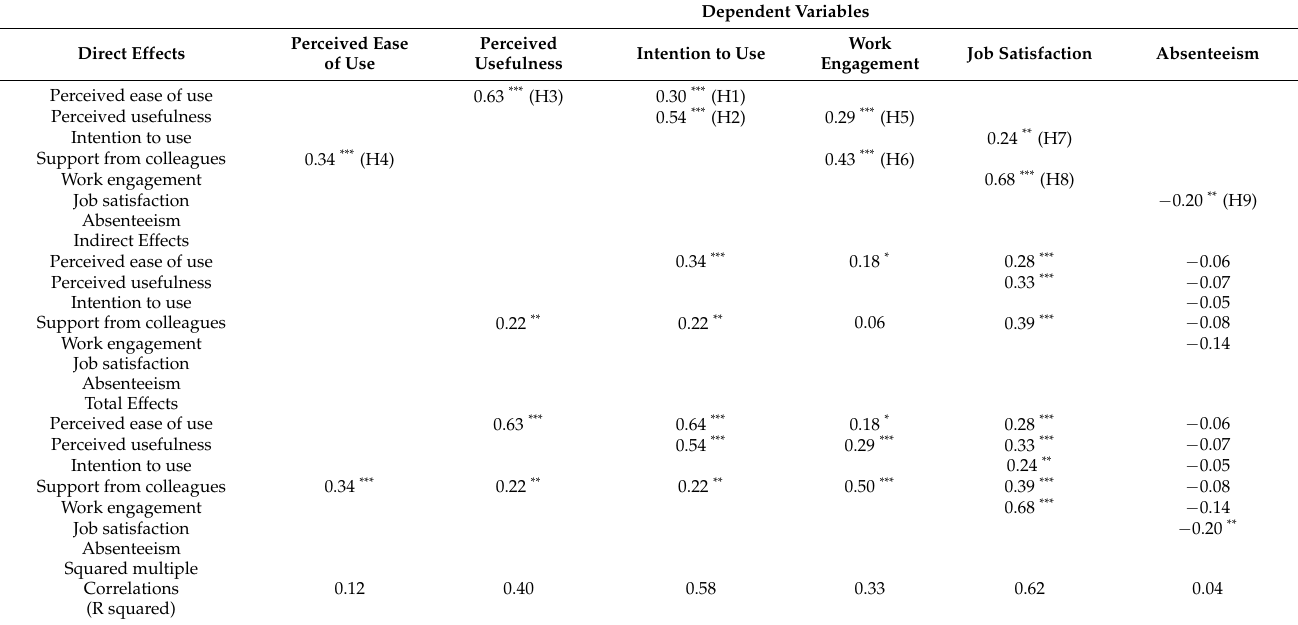
Figure 2. The tested model ( N = 122). Note: Every effect is statistically significant at p < 0.01; italicized numbers present the squared multiple correlations. Table 2. Standardised effects ( N =